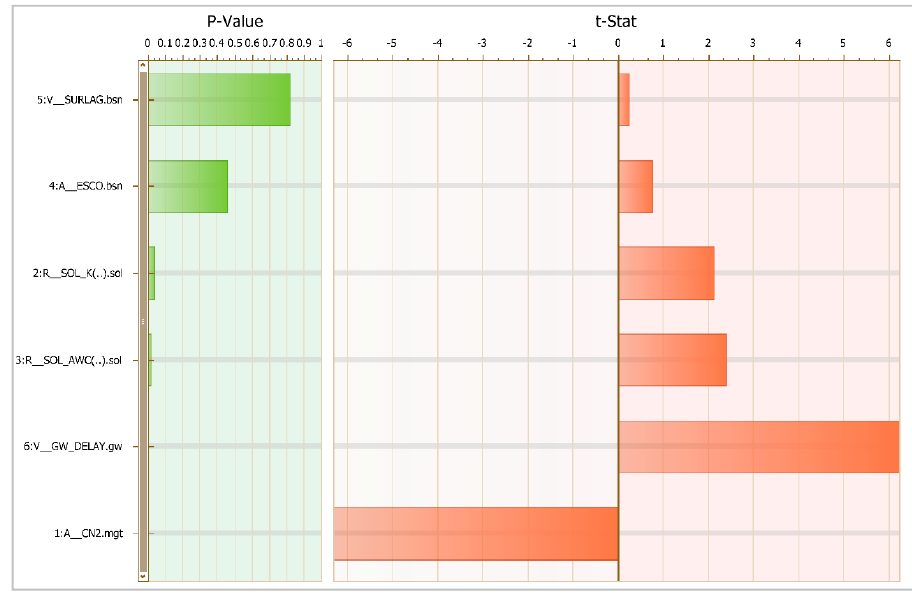
Figure 7. Parameterss global sensitivity analysis results for the final calibration iteration against NSE objective function.